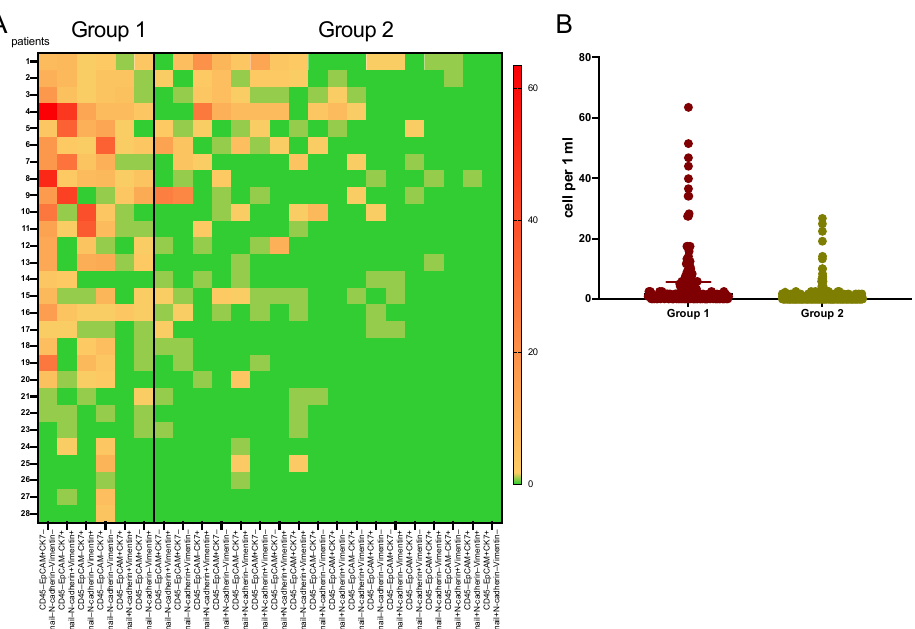
Figure 2. Heat map of the number of CTCs with various phenotypes. CTC phenotypes are located from left to right in decreasing order of their number. The frequency of occurrence ( A ) of each of the CTC phenotypes located from left to right in decreasing order of their maximal number. Vertical line divide CTC phenotypes by two groups (the numerous and the small). The median number of the CTCs from groups ( B ).